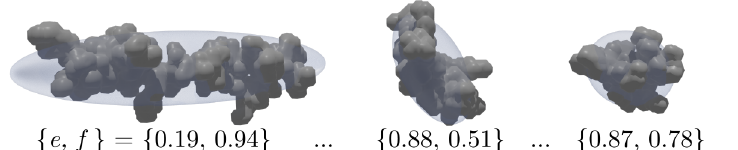
Figure 1. Image of three different three dimensional (3D) aggregates and their corresponding inertia ellipsoid illustrated as a transparent hull. Elongation e and flatness f values for each ellipsoid are displayed below each